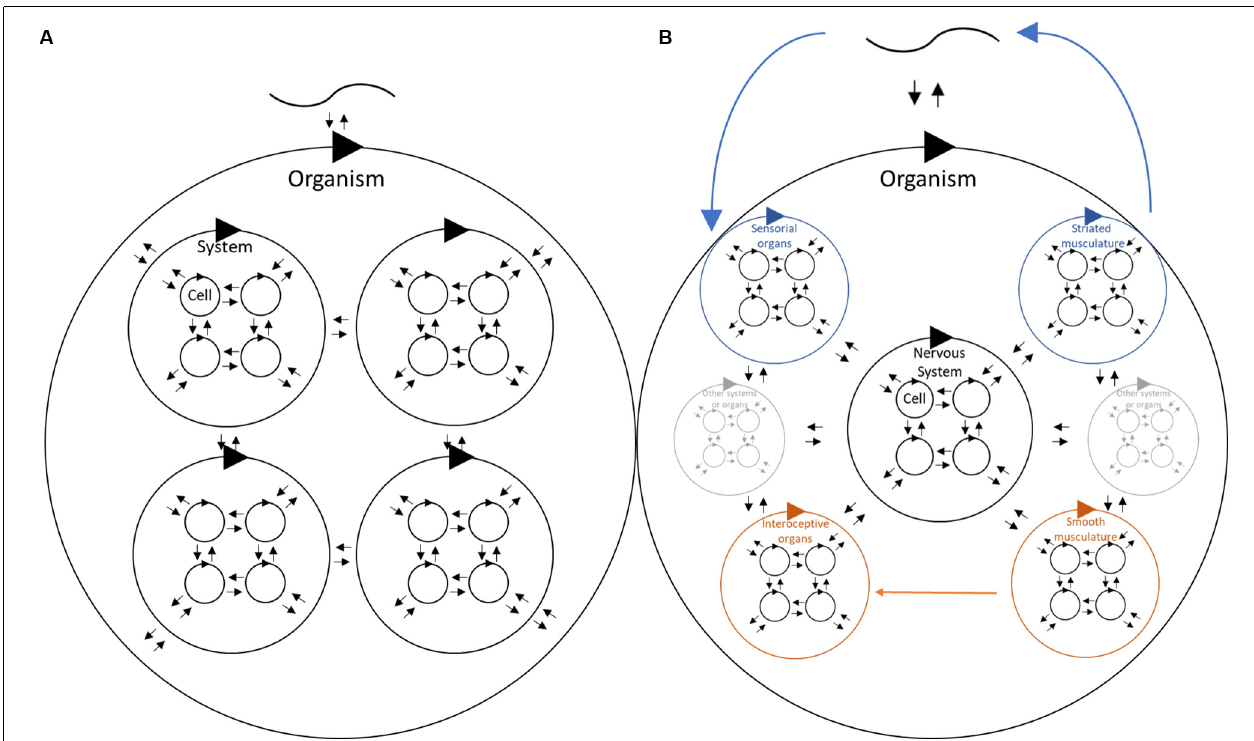
FIGURE 1 | Schematic hierarchical structure and interactions for (A) a generic living organism, and (B) highlighting particular features of the nervous system. In (A) self-closed arrows distinguish an operation closure denoting a certain level of independence of its internal operations. Bidirectional arrows for each self-closed arrows denote the local interactions at each level (cell, system, organism), highlighting the relevance of local interactions. The cohesive and codependent interactions that lead to the emergence of a system as a recognizable unit are represented by a bigger circle denoting a self-closed arrow containing those local interactions (i.e., System, Organism). These systems may also interact with each other at a higher level (in terms of space and time) of interactions. Finally, the codependence of these systems will finally produce what we recognize as an organism following the same rationale, while then interactions are established with what we traditionally recognize as the environment (depicted by the upper curve). In the case of (B) , we highlighted the sensorimotor loop (internal and external), as well as the structure of sensorial structures, middle structures (traditionally referred to as processing related areas), and finally effectors. In this figure, we highlighted only muscles, but effectors cover a major range of structures, such as